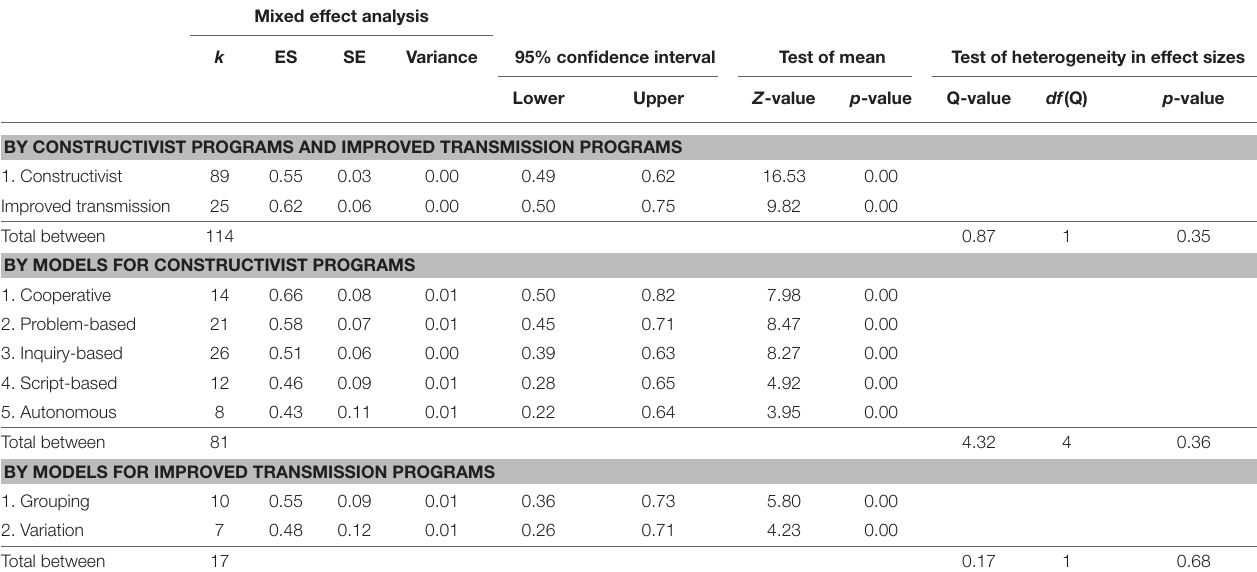
TABLE 6 | Moderator analyses by teaching and learning